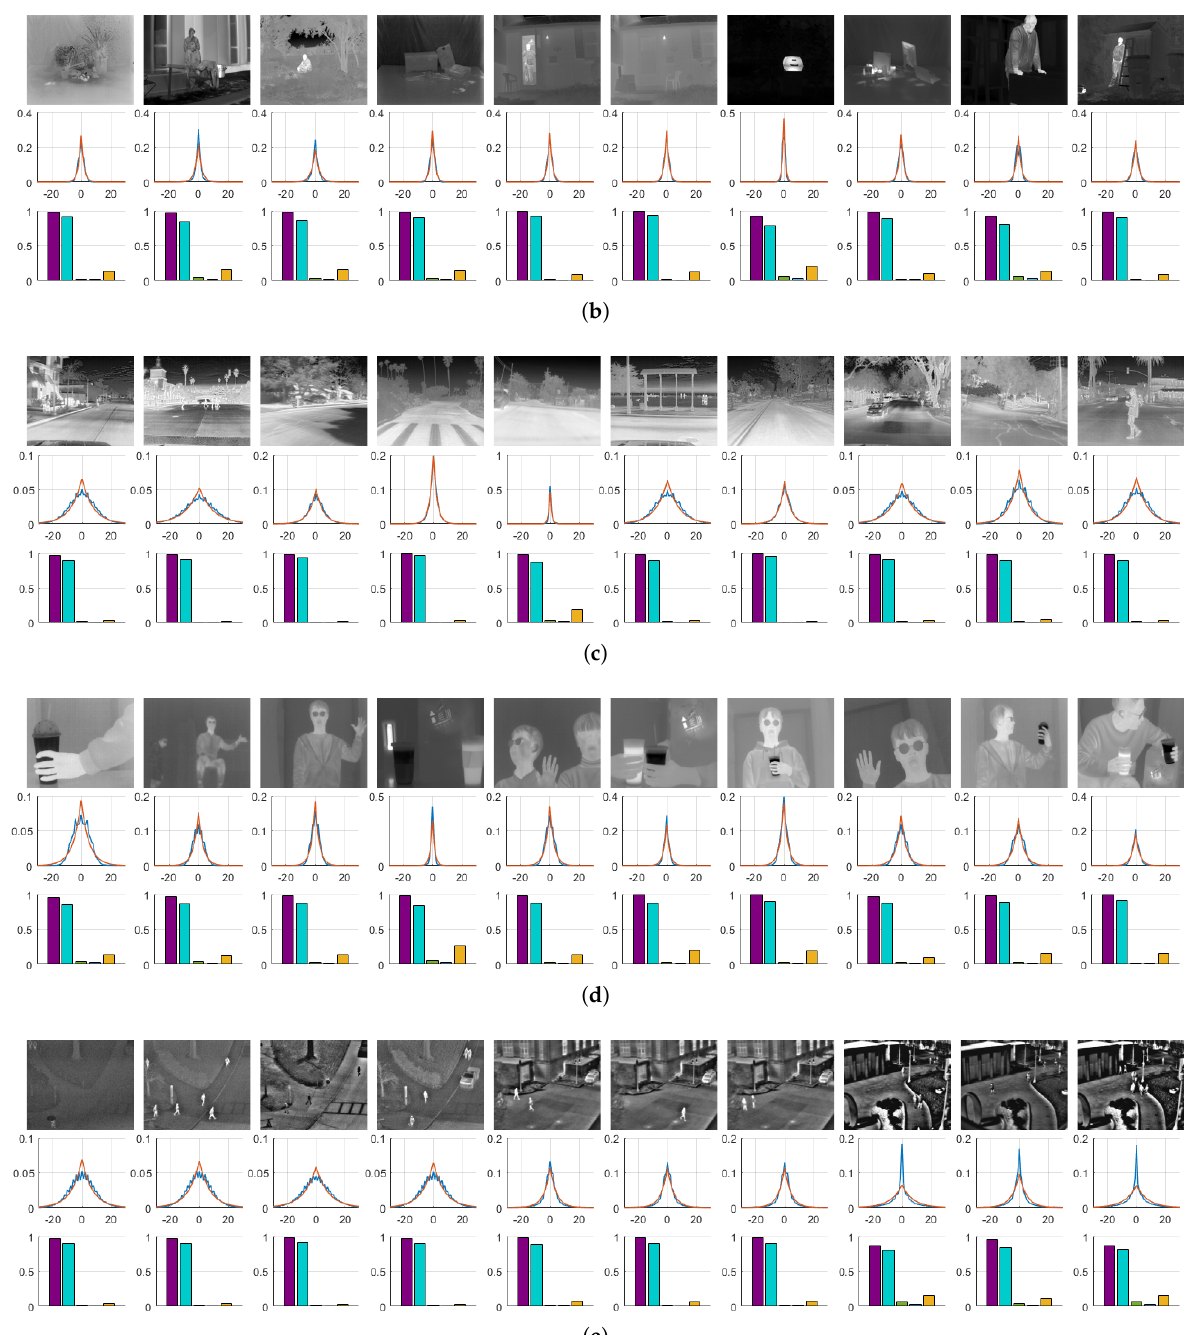
Figure 2. LWIR images, histograms, and the measured similarity. Ten images are sampled from each dataset, and the observed and estimated gradient distributions are demonstrated. The similarities between the observed and estimated distributions are also visualized. In most cases, measurement scores show that the two distributions are closely